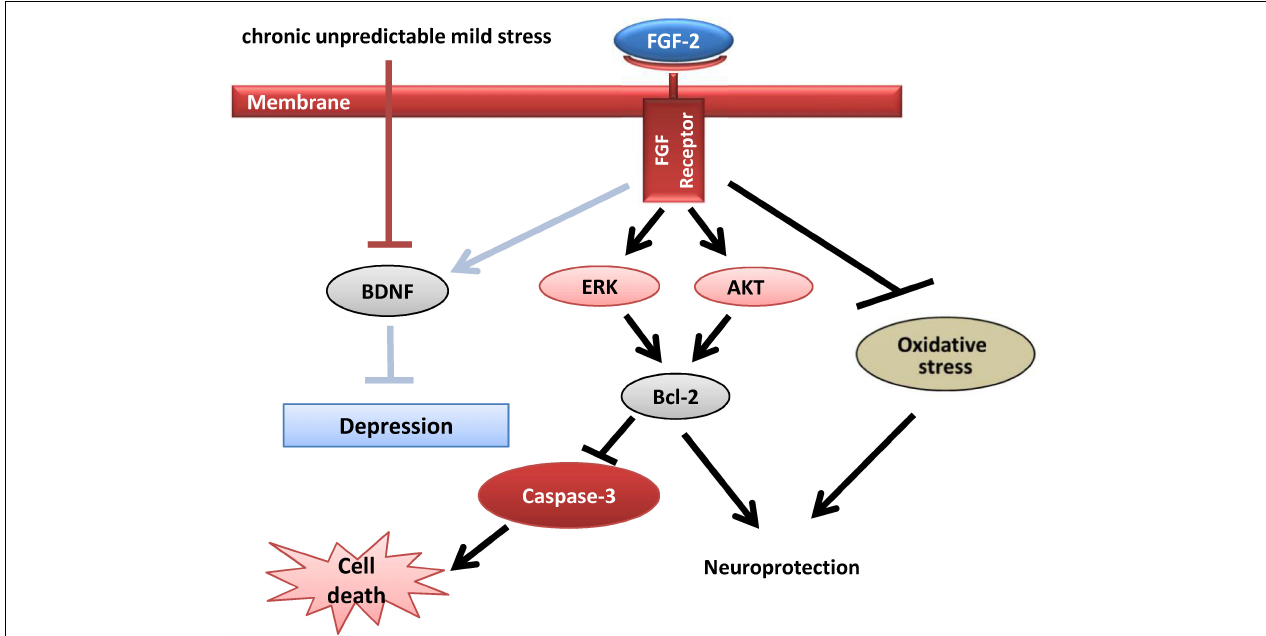
FIGURE 7 | Potential mechanism of the antidepressant effect of FGF-2. FGF-2 activates the ERK and AKT signaling pathways by acting on FGFR1, which upregulates the expression of the antiapoptotic protein Bcl-2, leading to decreased caspase-3 levels. Upregulated BDNF protein expression ameliorates the symptoms of CUMS-induced depression, which may in turn increase Bcl-2 expression and inhibit caspase-3. In addition, the inhibition of oxidative stress exerts antidepressant effects on CUMS-induced mice.